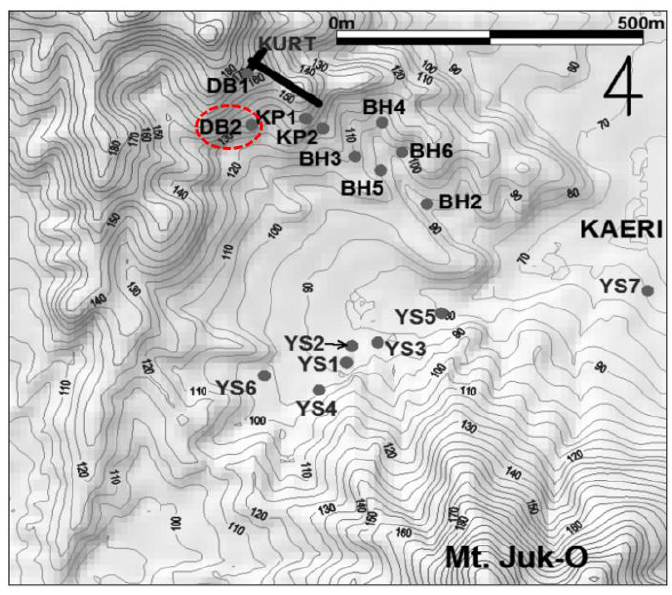
Figure 7. Location map for the DB-2 borehole.